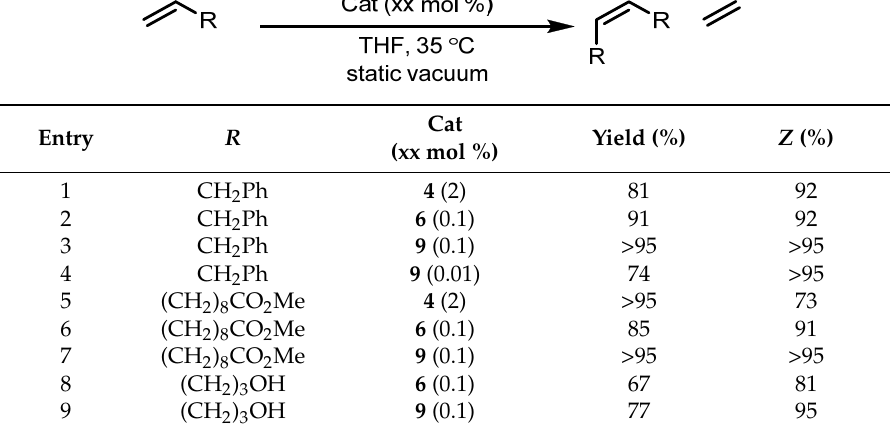
Table 1. Homodimerization of terminal olefins using cyclometalated catalysts.